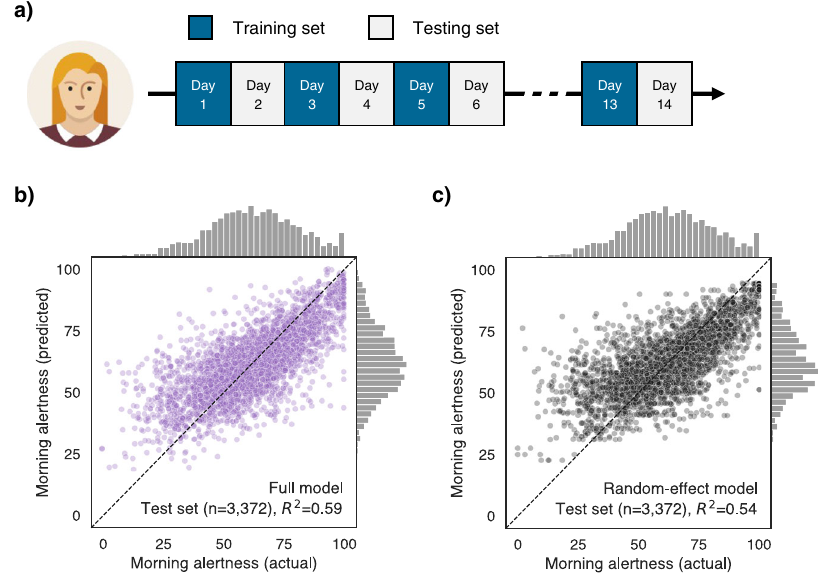
Fig. 4 | Predictions of morning alertness from the hold-out validation. a Hold- out validation strategy. For each participant, the multilevel model was trained on half the available days and then tested on the remaining half. Predictors of the multilevel model are shown in Fig. 3. The dependent variable of the model is morning alertness, which is calculatedby averaging the alertness ratings thatwere made within the fi rst three hoursafter breakfast start. Family ID and participant ID were de fi ned as nested random effects of the linear mixed model. b Scatter plot